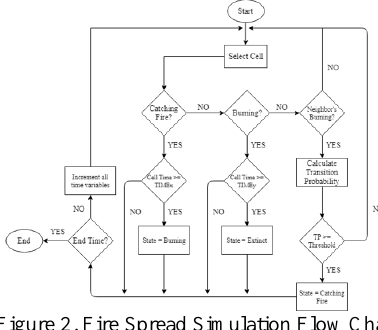
Figure 2. Fire Spread Simulation Flow